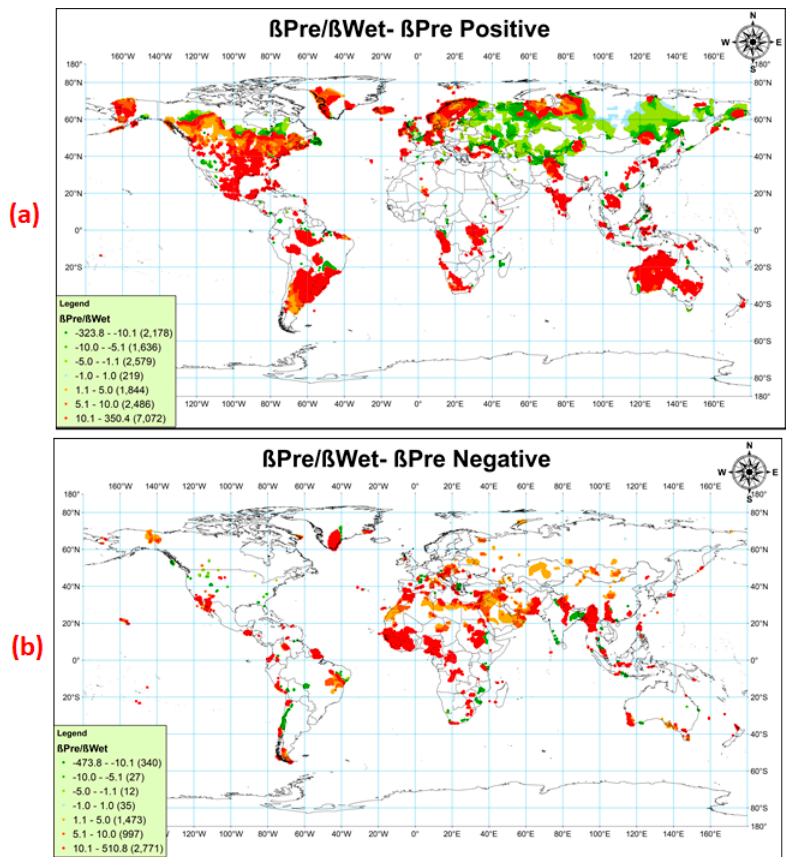
Figure 3. Relative change in trends of Pre with the trend of Wet. ( a ) Pre trend positive, ( b ) Pre trend negative. The value of ßPre / ßWet close to unity (indicated by light shades of green and red color) is assumed insignificant as it suggests a lesser amount of Pre trend than Wet. As represented in Figure 2a,c the magnitude of the ßWet is much lesser than ßPre, so the ßPre / ßWet close to unity (also lesser than unity) indicates very small Pre trend.